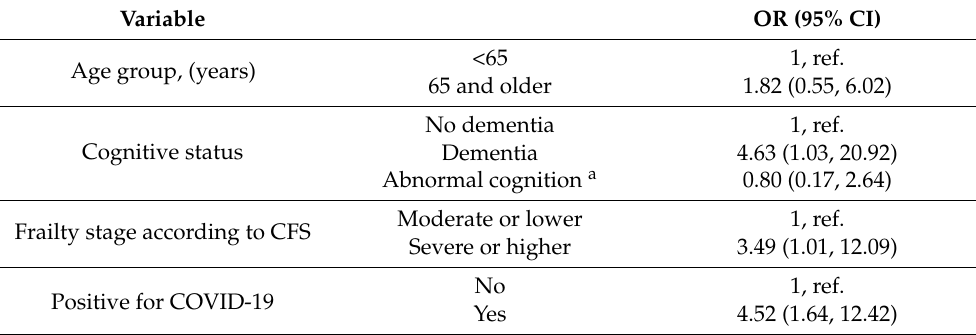
Table 3. Factors predicting decisions for less aggressive care post-intervention.